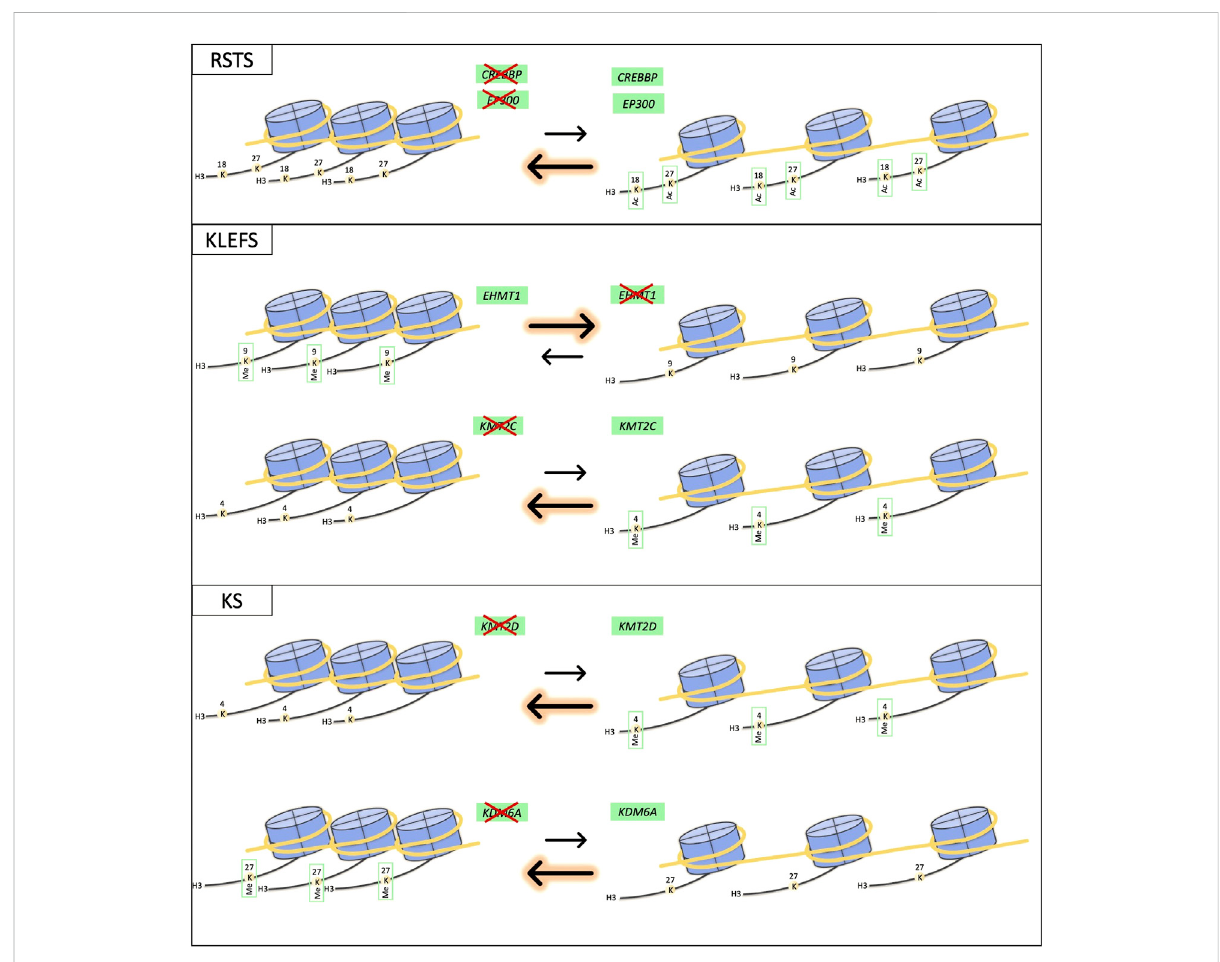
FIGURE 1 Schematic representation of effects on chromatin equilibrium for RSTS, KLEFS and KS syndromes. The drawing shows the impact of abnormal function of proteins coded by different genes having common effects on chromatin state equilibrium.